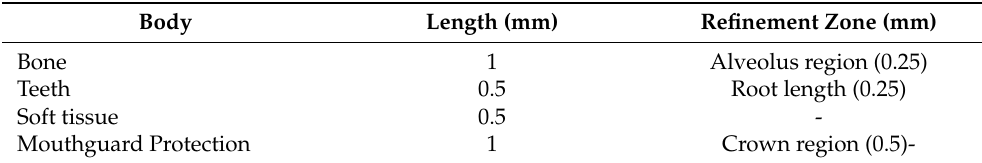
Table 2. Description of the length of element edge attributed to each body and the refinement areas.